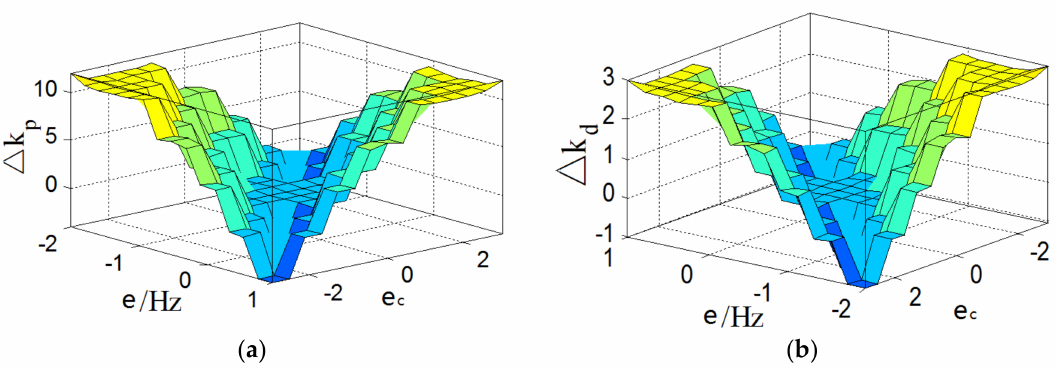
Figure 4. Fuzzy adaptive PD corrected parameters drawing. ( a ) Drawing of ∆ k p ; ( b ) Drawing of ∆ k d . and ∆ k p .